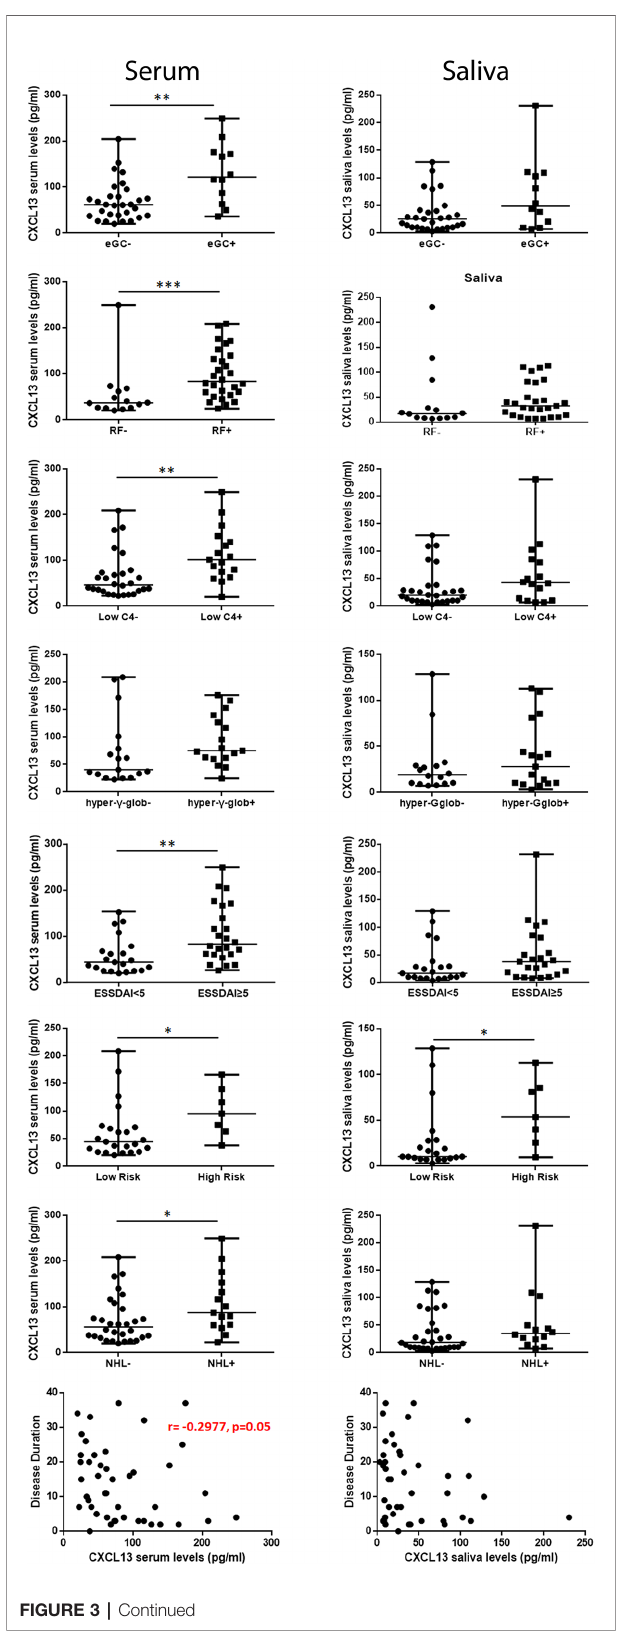
FIGURE 3 | Association of CXCL13 serum and saliva levels with histologic, laboratory and clinical features. Mann-Whitney non-parametric analysis revealed that CXCL13 serum levels were signi fi cantly increased in pSS patients with ectopic germinal centers (eGCs) in the MSG in fi ltrates, presence of rheumatoid factor (RF), C4-hypocomplementemia (Low C4), hypergammaglobulinemia (hyper- g -glob), high ESSDAI score (ESSDAI ≥ 5), high risk to develop NHL (high risk) and NHL, whereas they were inversely correlated with disease duration. CXCL13 saliva levels were signi fi cantly increased in patients at high risk to develop NHL. P-values are designated by asterisks (*p < 0.05, **p < 0.01, ***p < 0.001), whereas horizontal bars represent the median value of